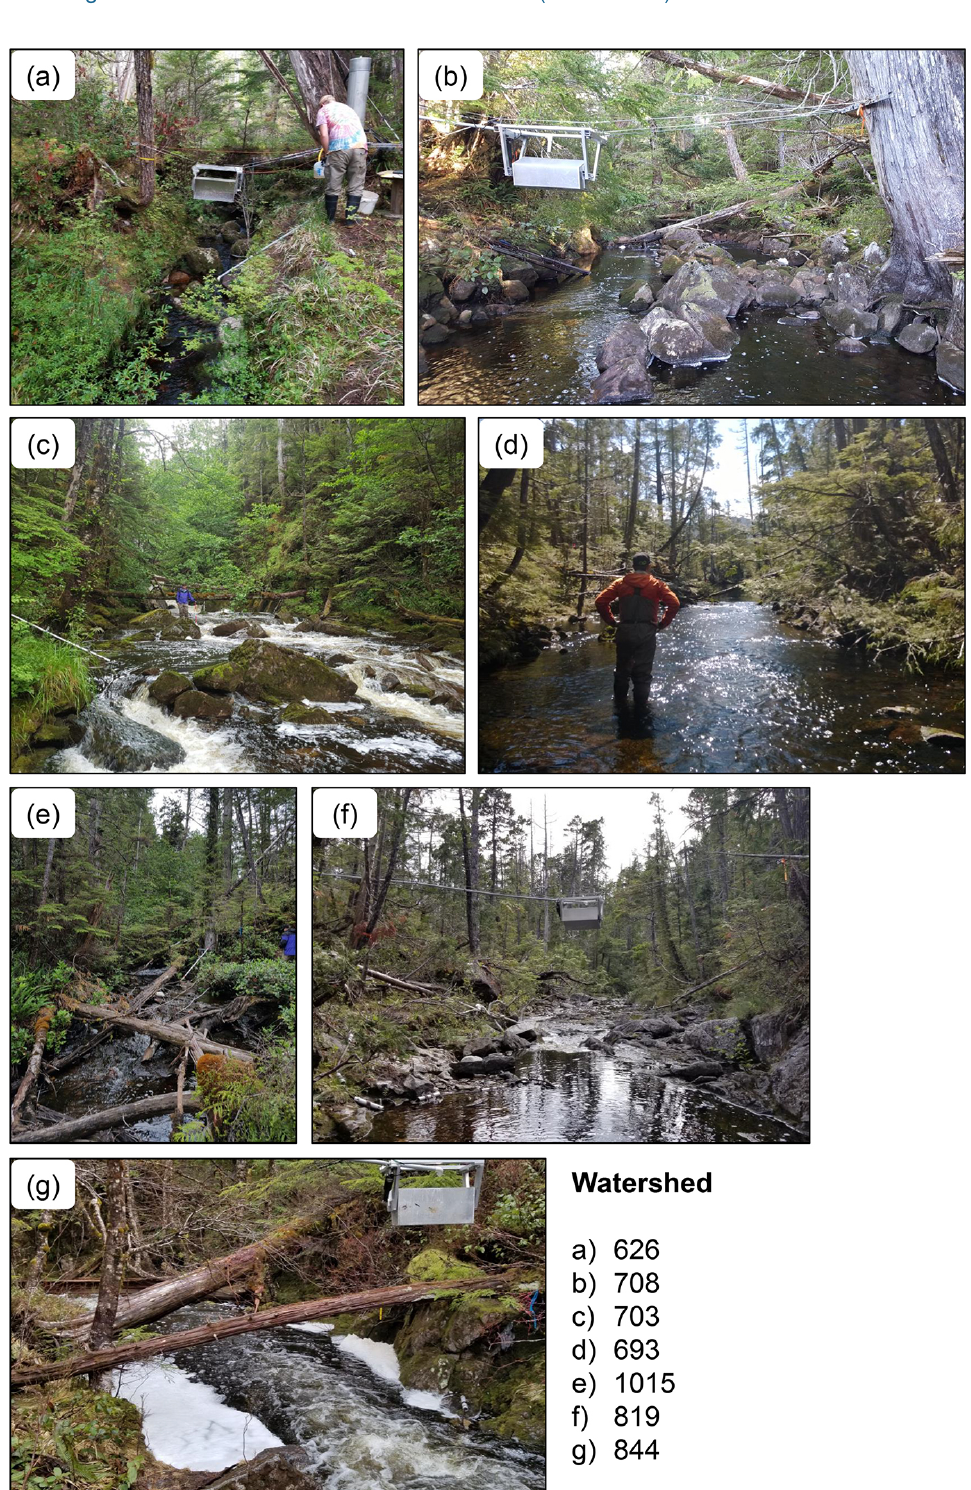
Figure A2. Images of the seven streams near the watershed outlets. Shown are the water level gauging site (watershed 693), the downstream sites of the automated salt-in-solution discharge measurement method (watersheds 703 and 1015), and the upstream sites of the automated salt-in-solution discharge measurement method with dumping mechanism (all other watersheds). Photos by Shawn Hateley, Bill Floyd, and Maartje